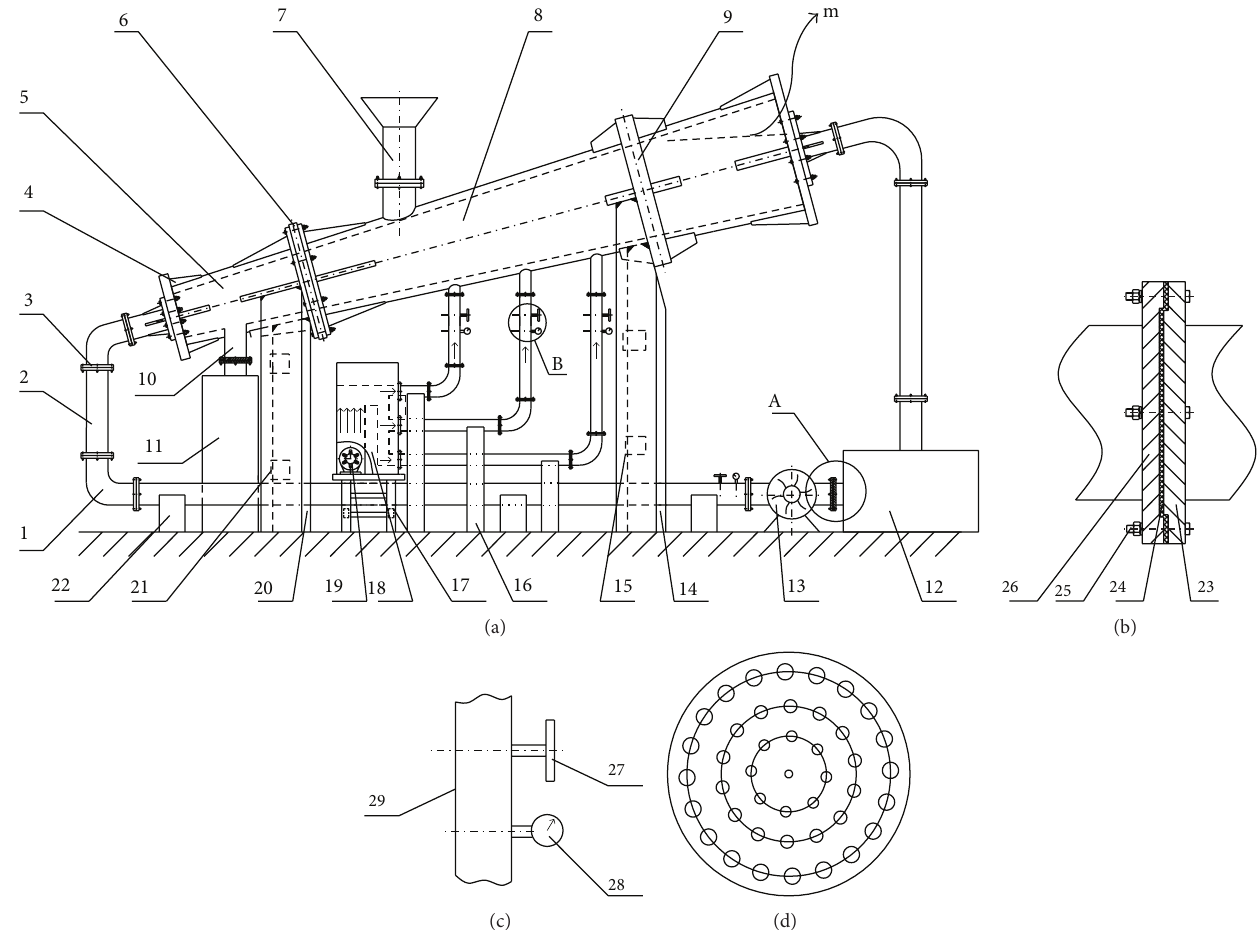
Figure 1: (a) ITDSB schematic. (b) Enlarged view of area A. (c) Enlarged view of area B. (d) Schematic of the hydraulic distributor. Note. 1—Elbow pipe, 2—straight pipe, 3—flat flange, 4—stiffener board, 5—front-end of TDSB, 6—hydraulic distributor, 7—feeding inlet, 8—back- end of TDSB, 9—bearing ring, 10—discharge port, 11—concentration tank, 12—circulating water tank, 13—circulating water pump, 14—the middle brace of the ITDSB back end, 15—bilateral brace, 16—straight pipe brace, 17—bellows block, 18—bellows, 19—air blower, 20—middle brace, 21—bilateral brace, 22—straight pipe brace, 23—convex flange, 24—filter cloth, 25—bolt, 26—concave flange, 27—valve, 28—flow meter, 29—fluid pipeline, and m—air-water